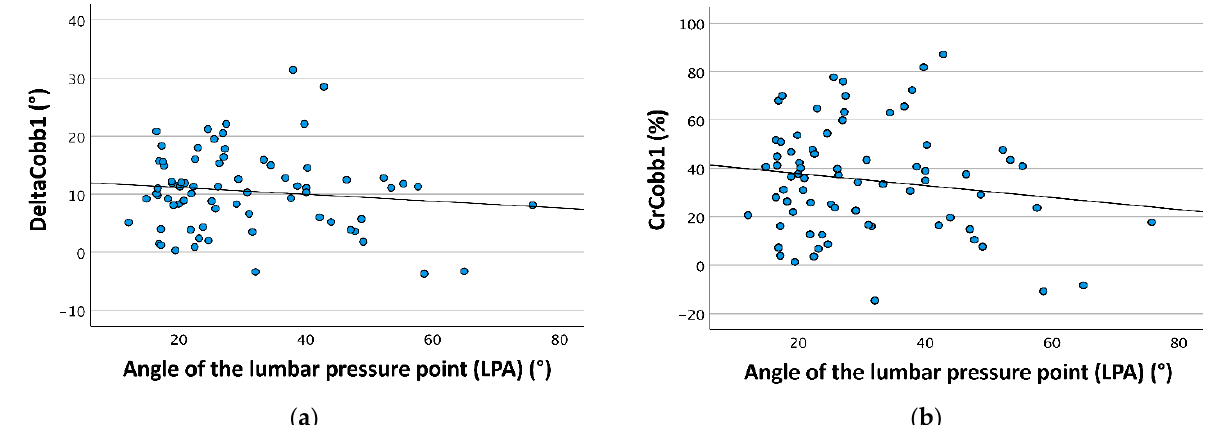
Figure 7. The figure demonstrates the distribution of the mean angular Cobb correction (DeltaCobb1) and mean Cobb angle correction rate (CrCobb1) in relation to the angle of the lumbar pressure point angle (LPA), which were significant in the multivariate general linear model (DeltaCobb1 p = 0.030, CrCobb1 p = 0.024). ( a ) The diagram shows LPA distribution in relation to DeltaCobb1. The black interpolated line demonstrates that with decreasing LPA, DeltaCobb1 increased. ( b ) The diagram shows LPA distribution in relation to CrCobb1. The black interpolated line demonstrates that with decreasing LPA, CrCobb1 increased.